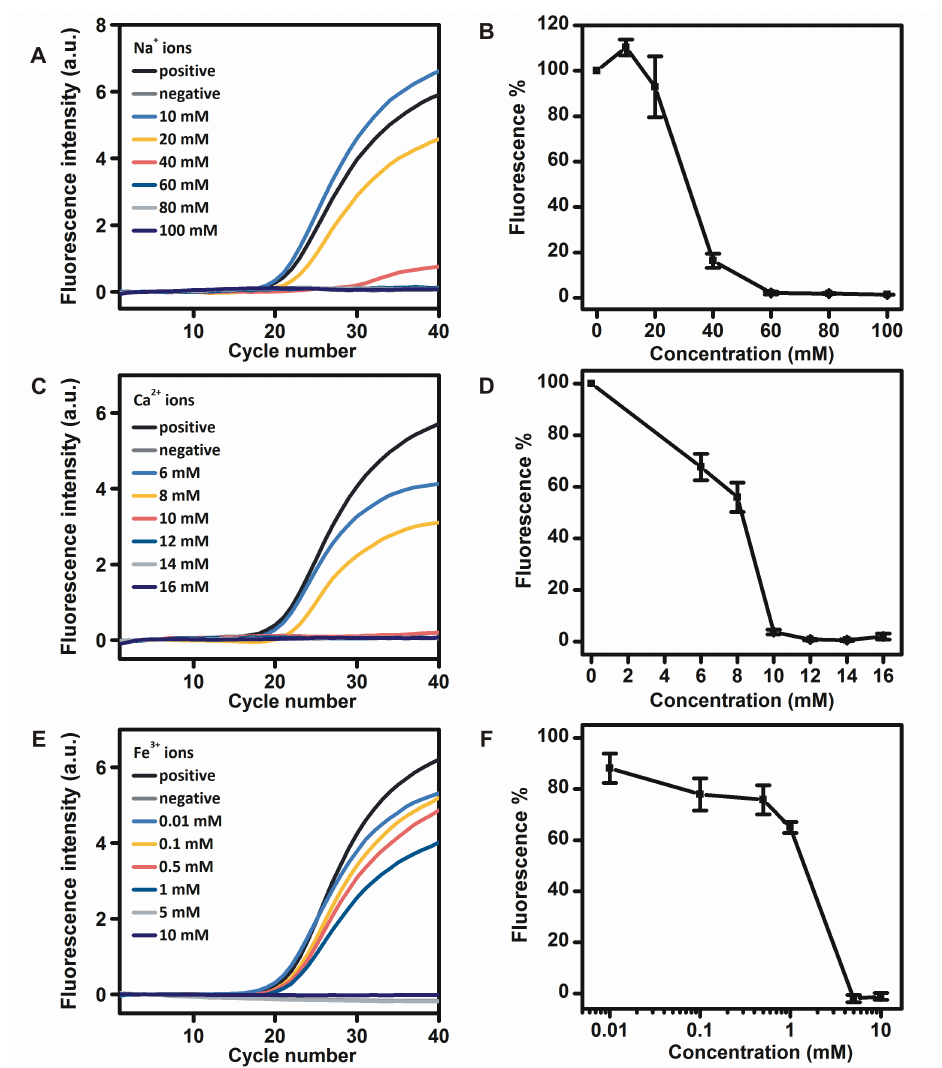
Fig 1. Inhibitory effects of different concentrations of Na + ions A, B), Ca 2+ ions C, D), and Fe 3+ ions E, F) on the RNA detection by r Tth polymerase.